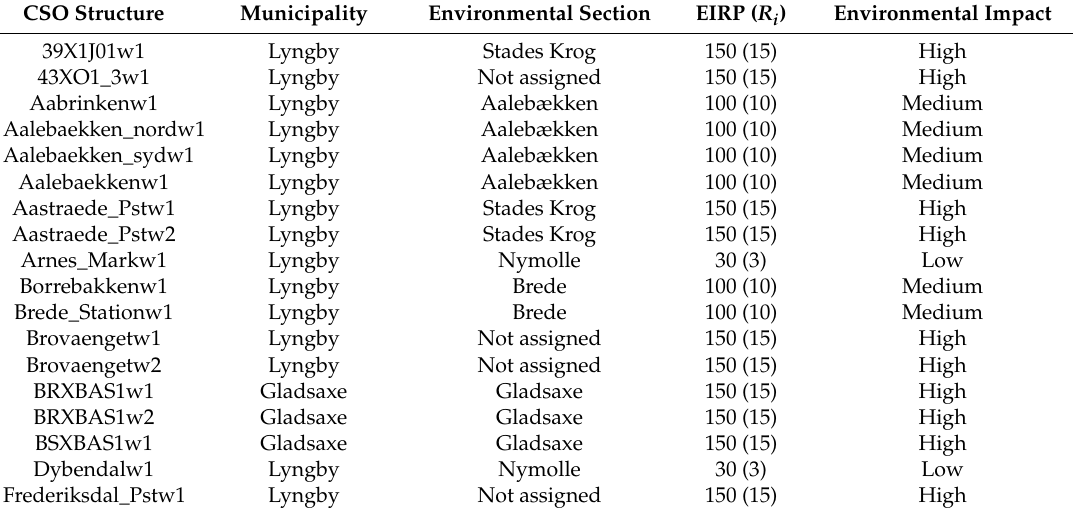
Table A1. List of the 47 CSO structures in the Lundofte catchment, along with the responsible municipality, Environmental Sections, EIRP with the corresponding is the risk factor R i in brackets, and Environmental Impact.